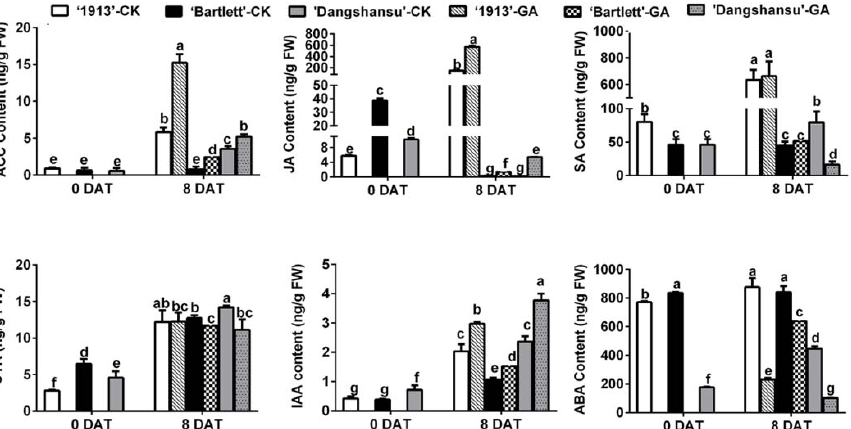
Figure 2. Hormone content of ovules at 0 and 8 DAT from ‘1913’, ‘Bartlett’ and ‘Dangshansu’, including ACC (aminocyclopropane-1-carboxylic acid, the precursor of ethylene), JA, SA, CTK (cytikinins), IAA and ABA. The samples at 8 DAT were collected from ovules with GA 4+7 treatment and untreated. DAT, days after treatment. The data are mean ± SD of three biological replicates. Error bars represent the standard deviation. Different lowercase letters indicate significant difference at p < 0.05 (Duncan’s multiple range